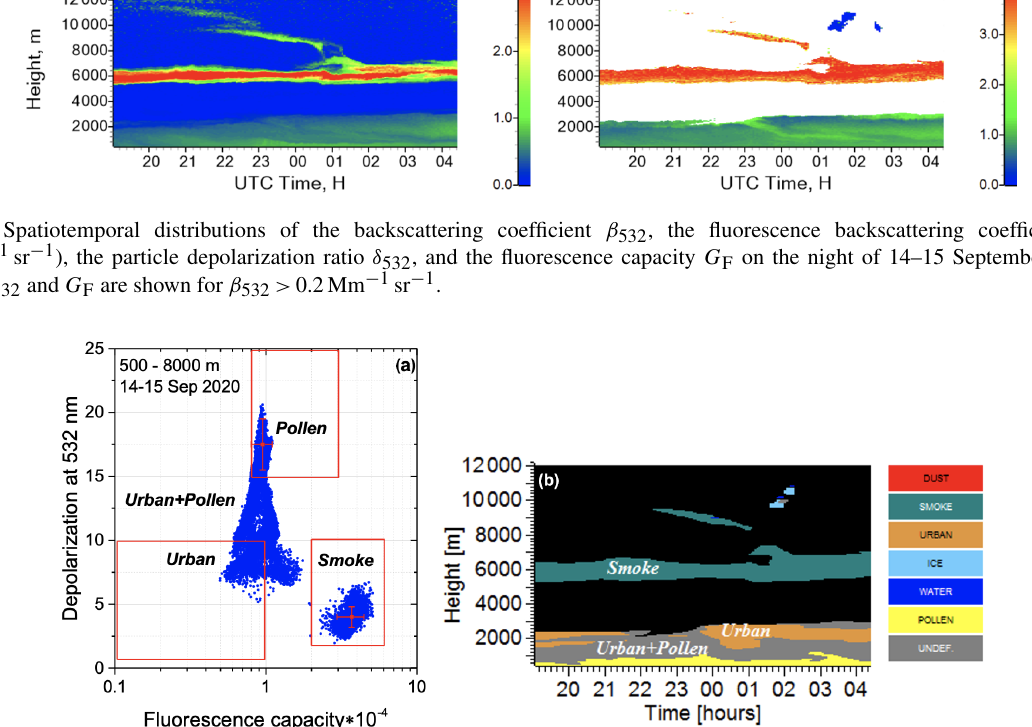
Figure 9. (a) The δ 532 - G F diagram for observations in the 500–8000m height range and (b) spatiotemporal distribution of aerosol types on the night of 14–15 September 2020. The gray coloring shows an undefined aerosol type, which is a mixture of pollen, urban, and smoke particles. Measurements with β 532 < 0.2Mm − 1 sr − 1 are marked in